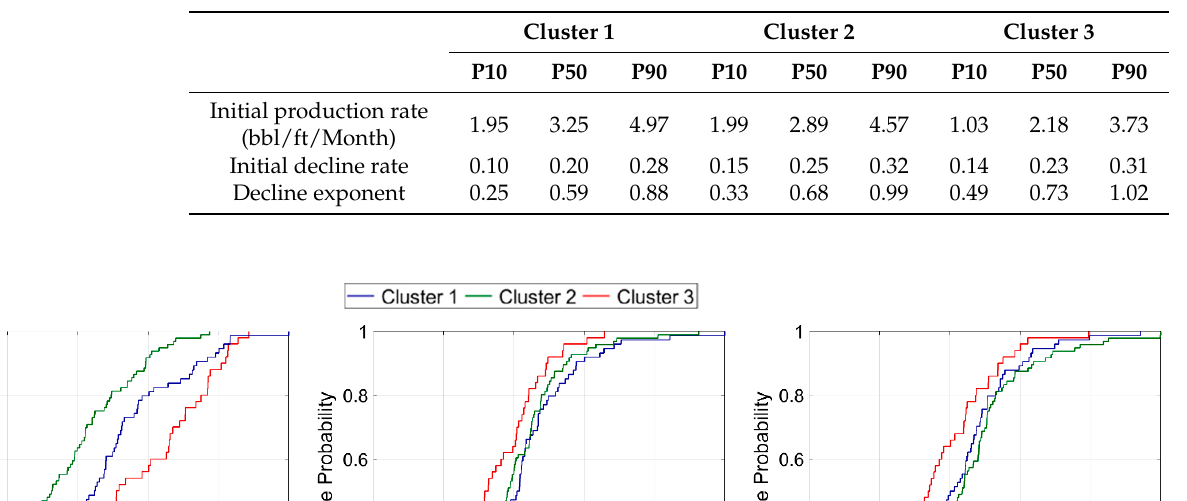
Table 6. Probability value of the DCA parameters by group.